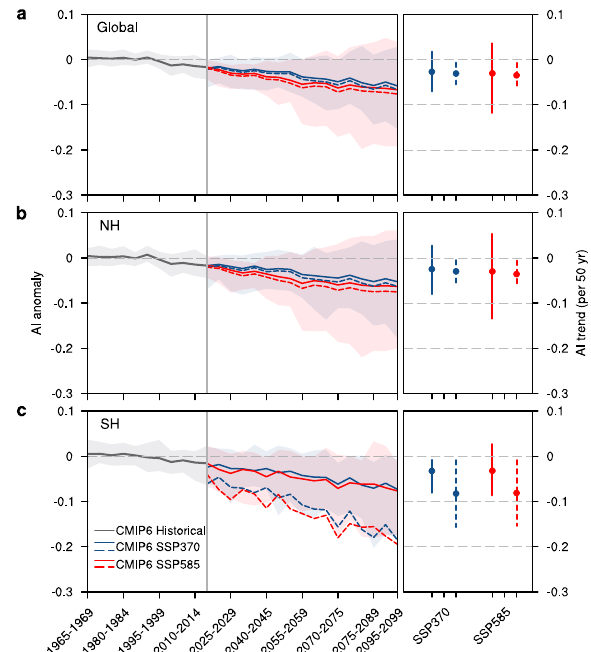
Fig. 4 Time series (left) and trends (right) of AI anomalies (relative to 1973 to 2002) for 1965 to 2099. Time series and linear trends (per 50 yr) of 5-yr mean annual AI anomalies over the globe ( a ), NH ( b ), and SH ( c ) for CMIP6 simulations. The ensemble means of historical ALL simulations are indicated with solid grey lines. The ensemble means for original future projection are given in dark blue and red solid lines for SSP3 − 7.0 and SSP5 − 8.5 ensembles, respectively, with blue and red shading represent the 5 – 95% ranges. The dashed lines indicate the corrected AI anomalies using the ALL scaling factors from 1-forcing analyses. The vertical solid and dashed bars show the trend uncertainty spread of original and corrected AI anomalies for SSP3 − 7.0 and SSP5 − 8.5 ensembles as labelled, respectively, with the dots indicating the mean